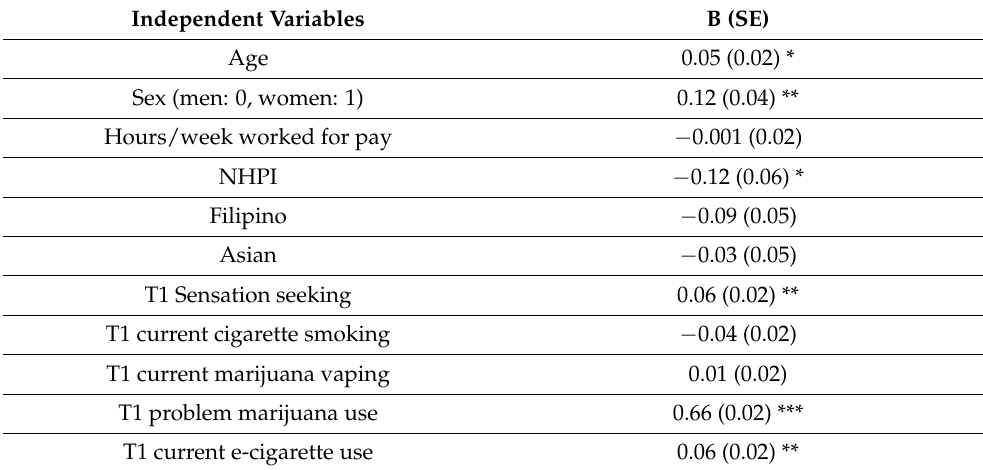
Table 3. The effects of baseline e-cigarette use on problem marijuana use at six-month follow-up. Independent